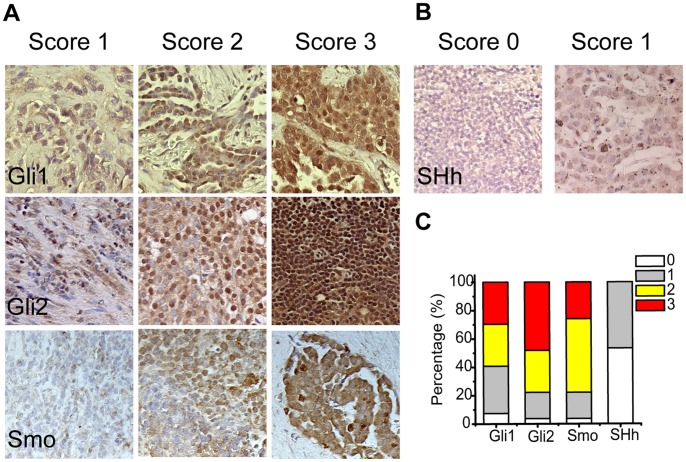
Protein Expression of Gli and SHh Pathway Components in MPM. A, Representative protein expression of Gli1(first row), Gli2(second row) and Smo (third row). Immunohistochemistry staining was scored as 0–3. Representative images of score 1 (first column), 2 (second column), and 3 (third column) were shown. B, Representative SHh protein expression. Representative images of score 0 (left panel) and score 1(right panel) were shown. C, Expression profiles of Gli1, Gli2, Smo, SHh in MPM tissues. Percentage of score 0–3 of Gli1, Gli2, Smo and SHh was summarized.